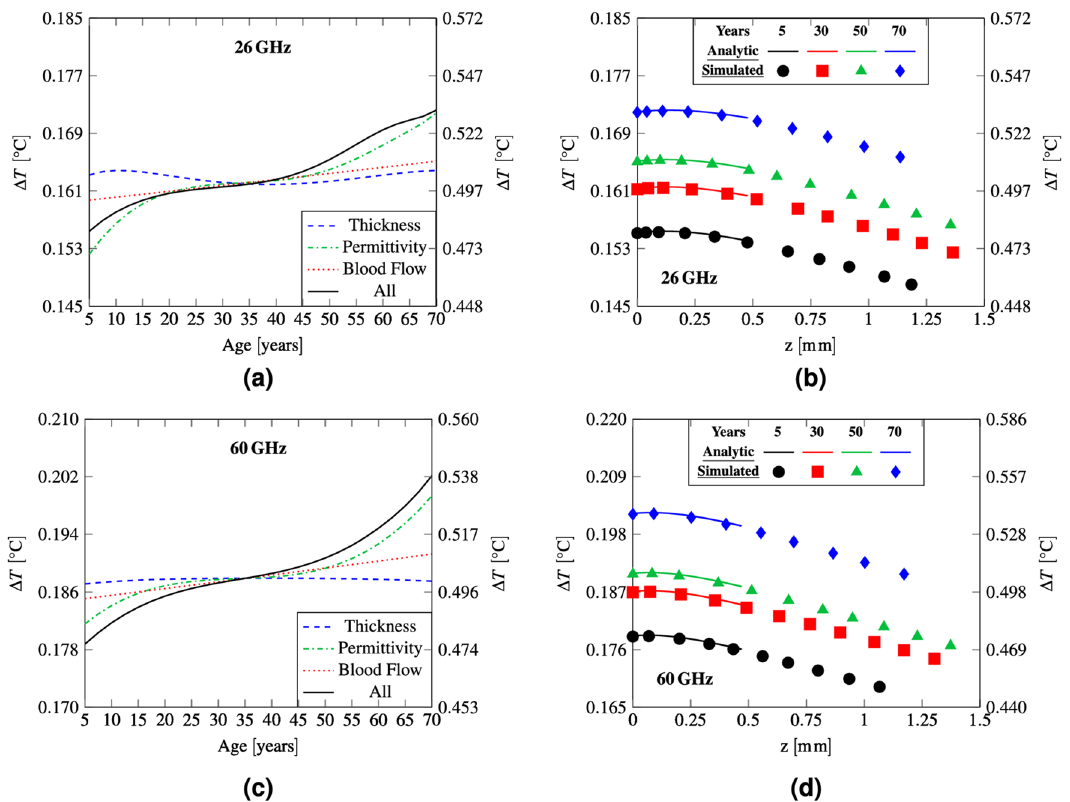
Figure 5. ( a , c ) Peak steady-state temperature elevation in skin as a function of age, ( b , d ) temperature elevation as a function of depth. The left y axis refers to the case of IPD equal to 10 W m −2 , while the right y axis corresponds to the frequency-dependent IPD limits for local